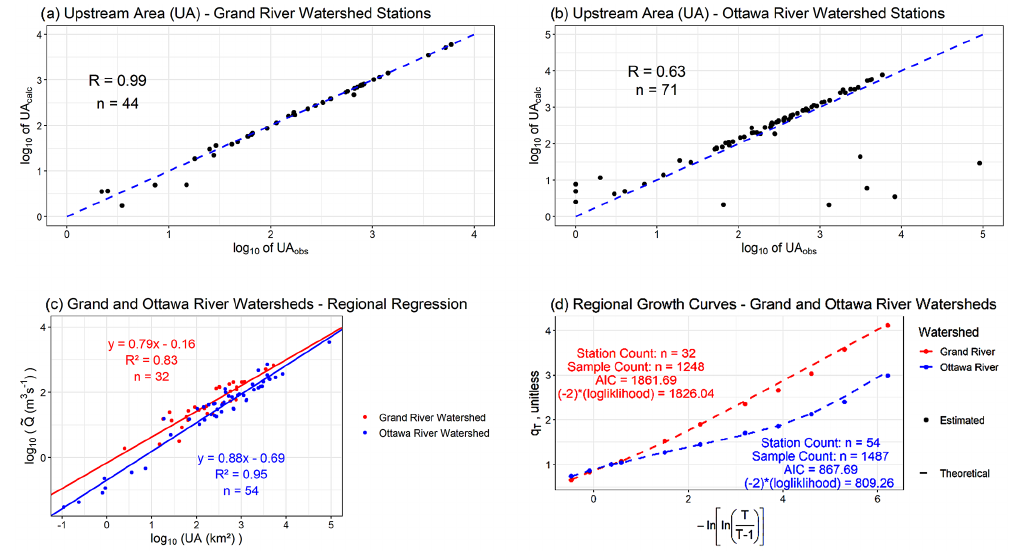
Figure 4. Flood frequency and regional regression